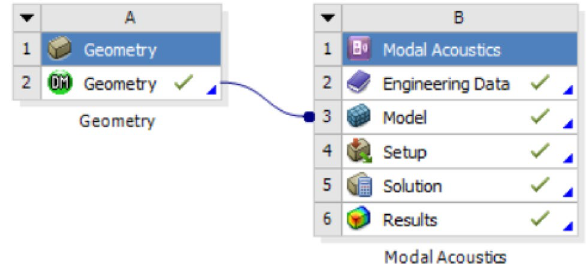
Fig. 27 Modal acoustics model in ANSYS workbench software